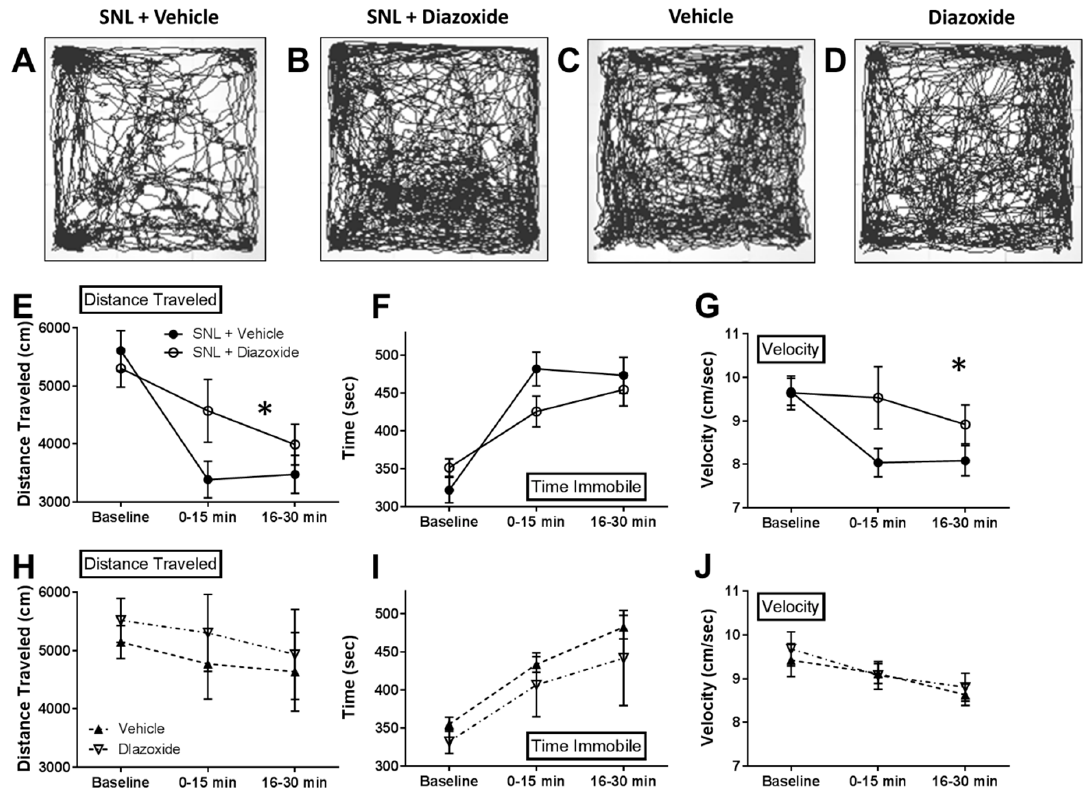
Figure 7. Intraplantar diazoxide increases mobility in mice after SNL. Open field testing (40 × 40 cm arena) used to track mouse movements before (15 min) and after (30 min total) intraplantar injection with saline ( A ) or diazoxide ( B , 100 µ M) after SNL or in uninjured mice ( C , D ). ( E ) Significant increase in distance traveled for diazoxide treated mice versus saline treated SNL mice (repeated measures ANOVA, F (2, 16) = 10.05, P < 0.05). ( F ) Time spent immobile was not significantly different between